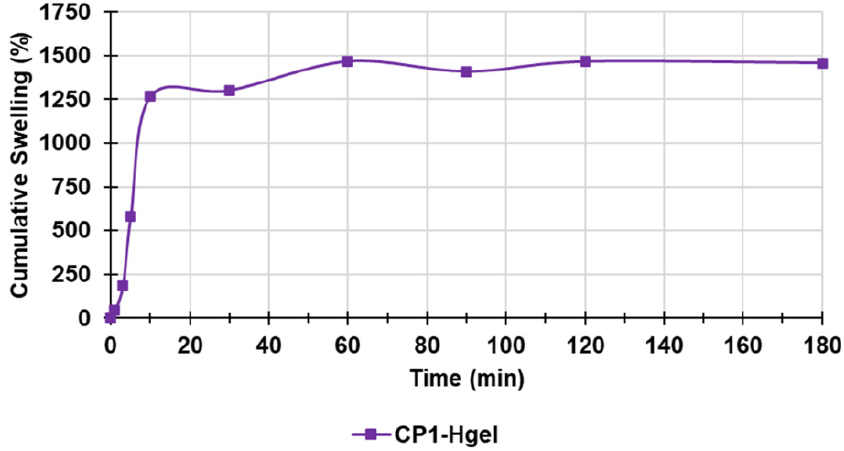
Figure 7. Cumulative swelling rate percentage curve of